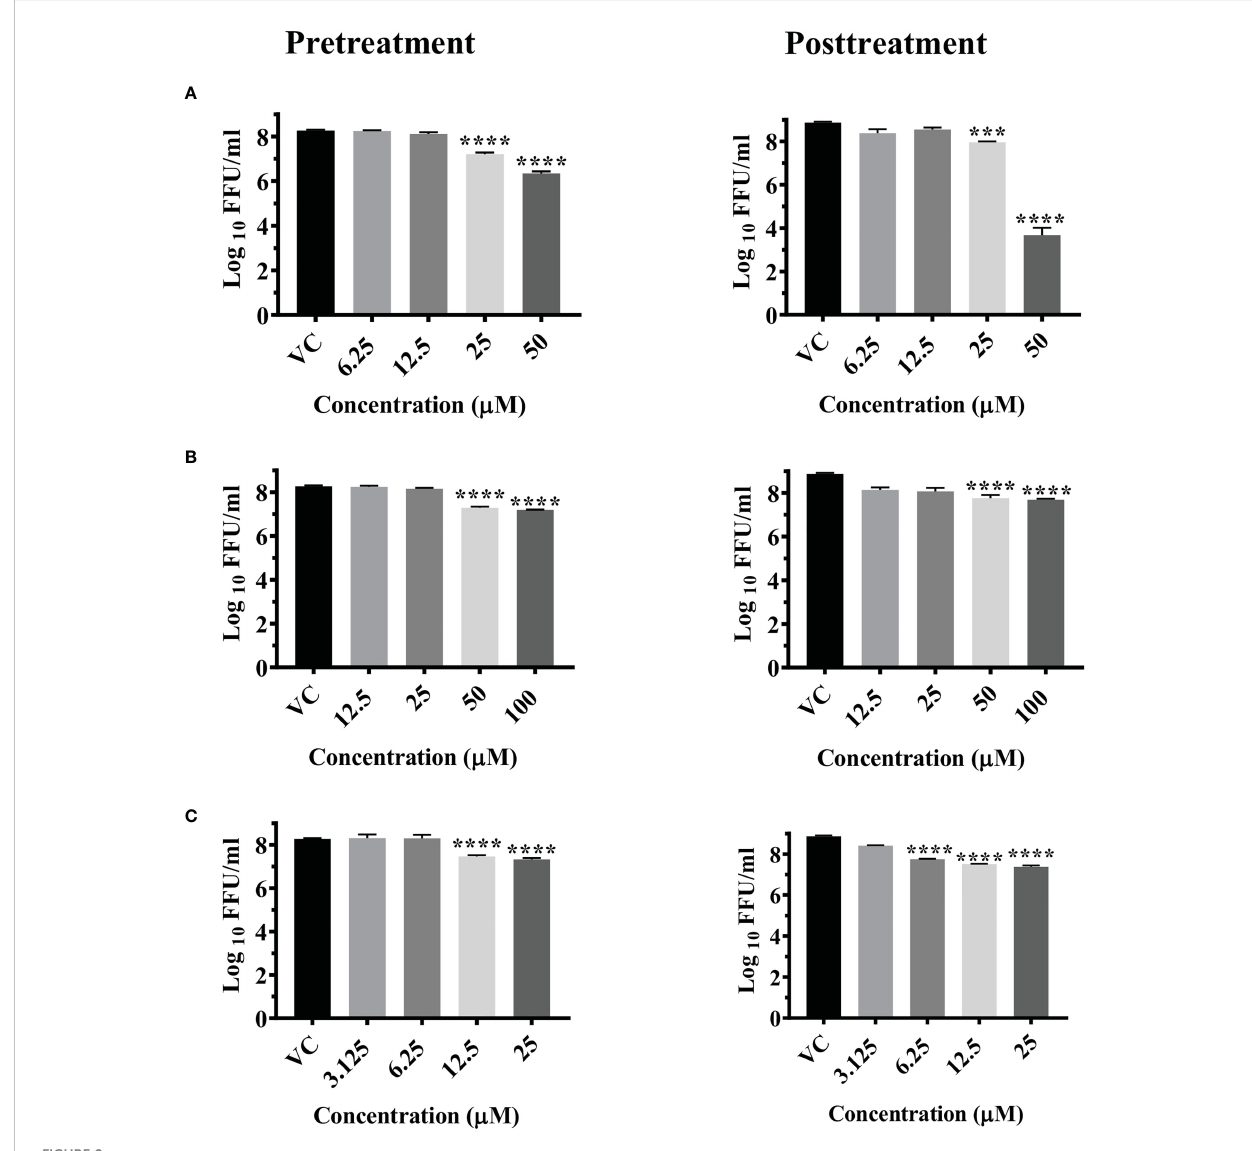
FIGURE 2 Antiviral effect of temsirolimus (A) , 2- fl uoroadenine (B) and doxorubicin (C) against CHIKV under pre and posttreatment conditions. Vero CCL-81 cells were pre and post treated with different concentrations of drug and incubated for 24 hrs. After incubation, culture supernatants were used for the FFU assay. The trials were carried out in triplicate at two different time points, and the outcomes are expressed as mean log 10 focus forming unit/ml ± standard error. All the treatment conditions were compared with the VC. **** (p<0.0001),